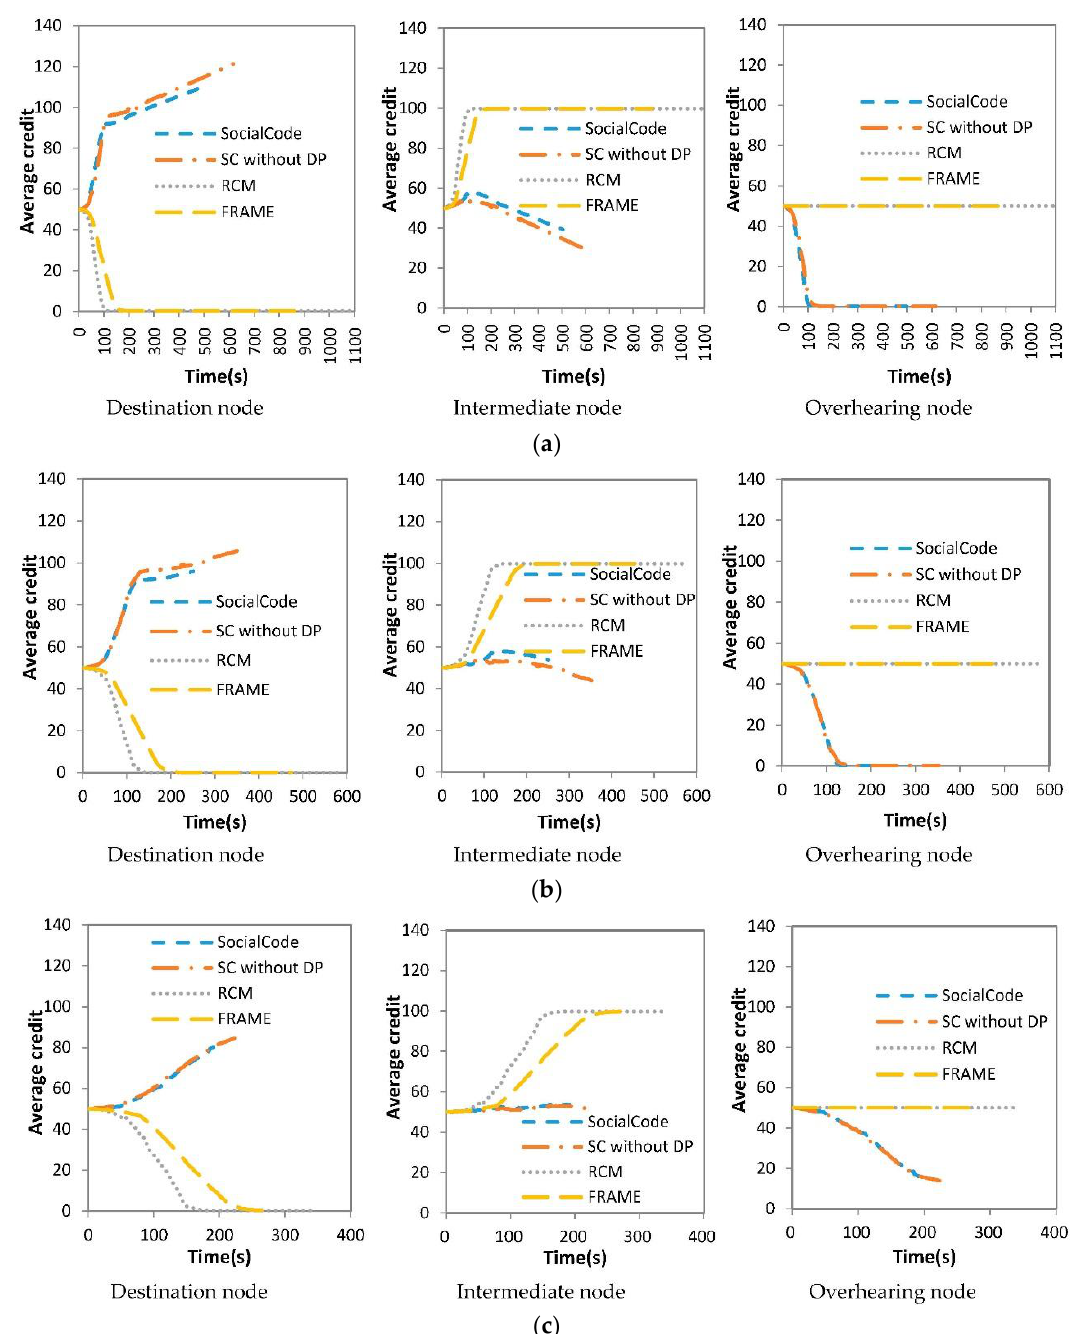
Figure 14. Average credit vs. the number of nodes ( a ) 3468 nodes; ( b ) 867 nodes; ( c ) 216 nodes.